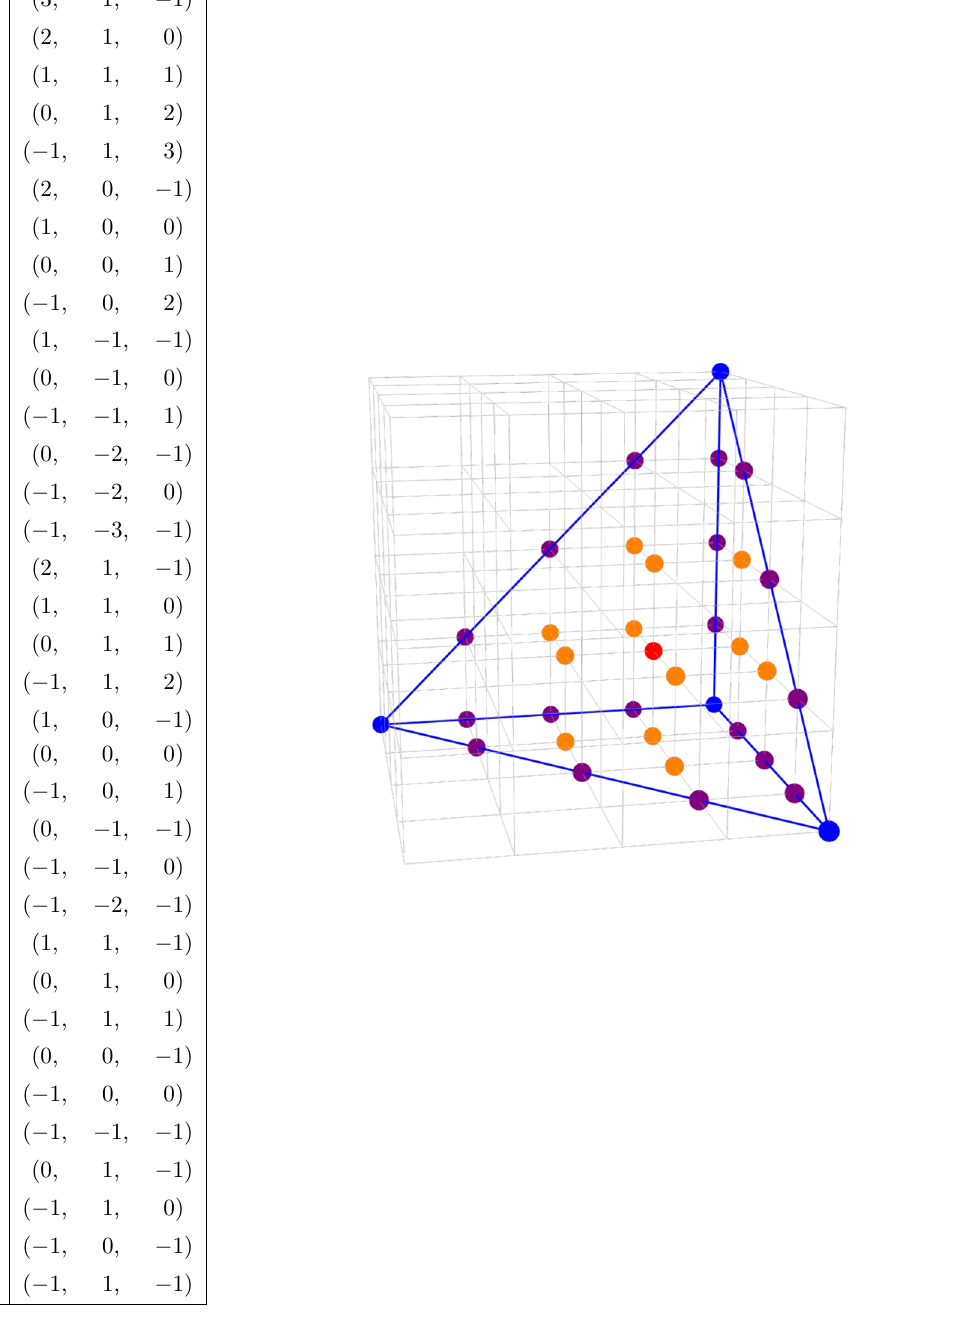
Table 7 . The generators and lattice of generators of the mesonic moduli space of Model 1 in terms of brick matchings with the corresponding flavor